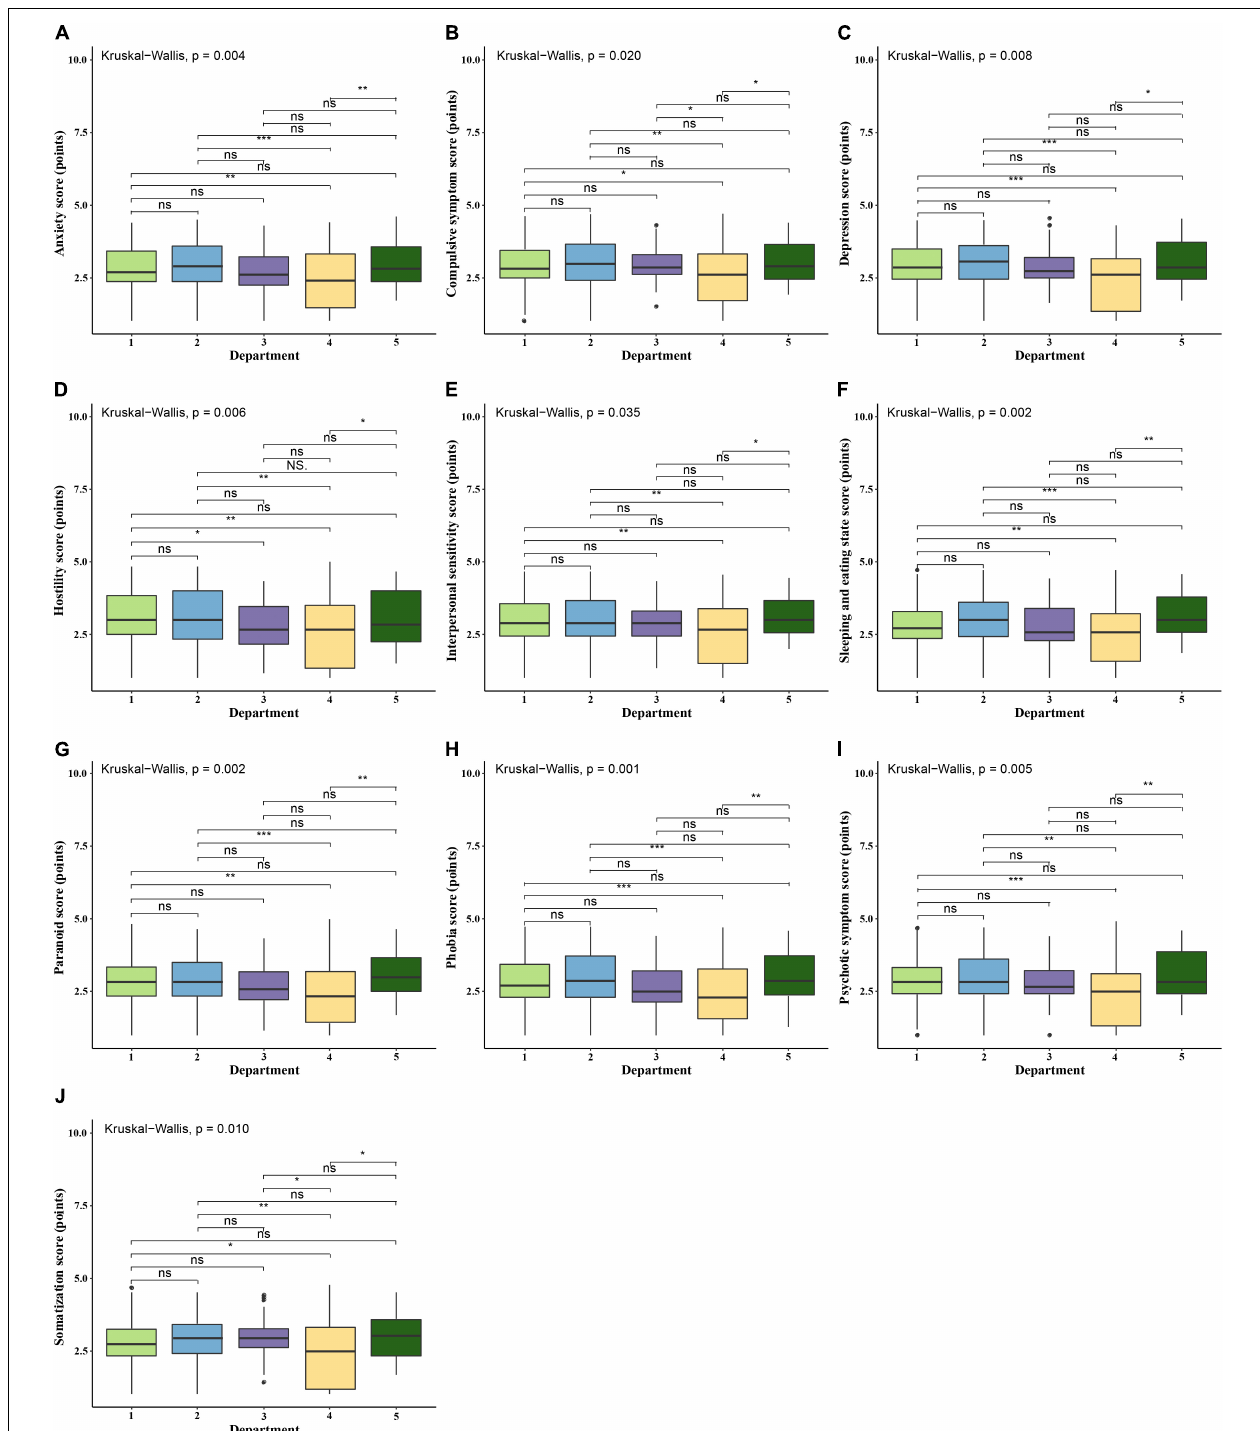
FIGURE 2 | Comparison of psychological evaluation scores of the resident physicians in different specialties. ns, not statistically significant. * p < 0.05; ** p < 0.01; *** p < 0.001; **** p < 0.0001. 1, Medical department; 2, Surgical department; 3, Obstetrics and gynecology department; 4, Pediatrics department; 5, Emergency room/ICU. (A) Comparison of scores of “Anxiety” among resident physicians in different specialties. (B) Comparison of scores of “Compulsive symptom” among resident physicians in different specialties. (C) Comparison of scores of “Depression” among resident physicians in different specialties. (D) Comparison of scores of “Hostility” among resident physicians in different specialties. (E) Comparison of scores of “Interpersonal sensitivity” among resident physicians in different specialties. (F) Comparison of scores of “Sleeping and eating habits” among resident physicians in different specialties. (G) Comparison of scores of “Paranoid” among resident physicians in different specialties. (H) Comparison of scores of “Phobia” among resident physicians in different specialties. (I) Comparison of scores of “Psychotic symptom” among resident physicians in different specialties. (J) Comparison of scores of “Somatization” among resident physicians in different specialties.